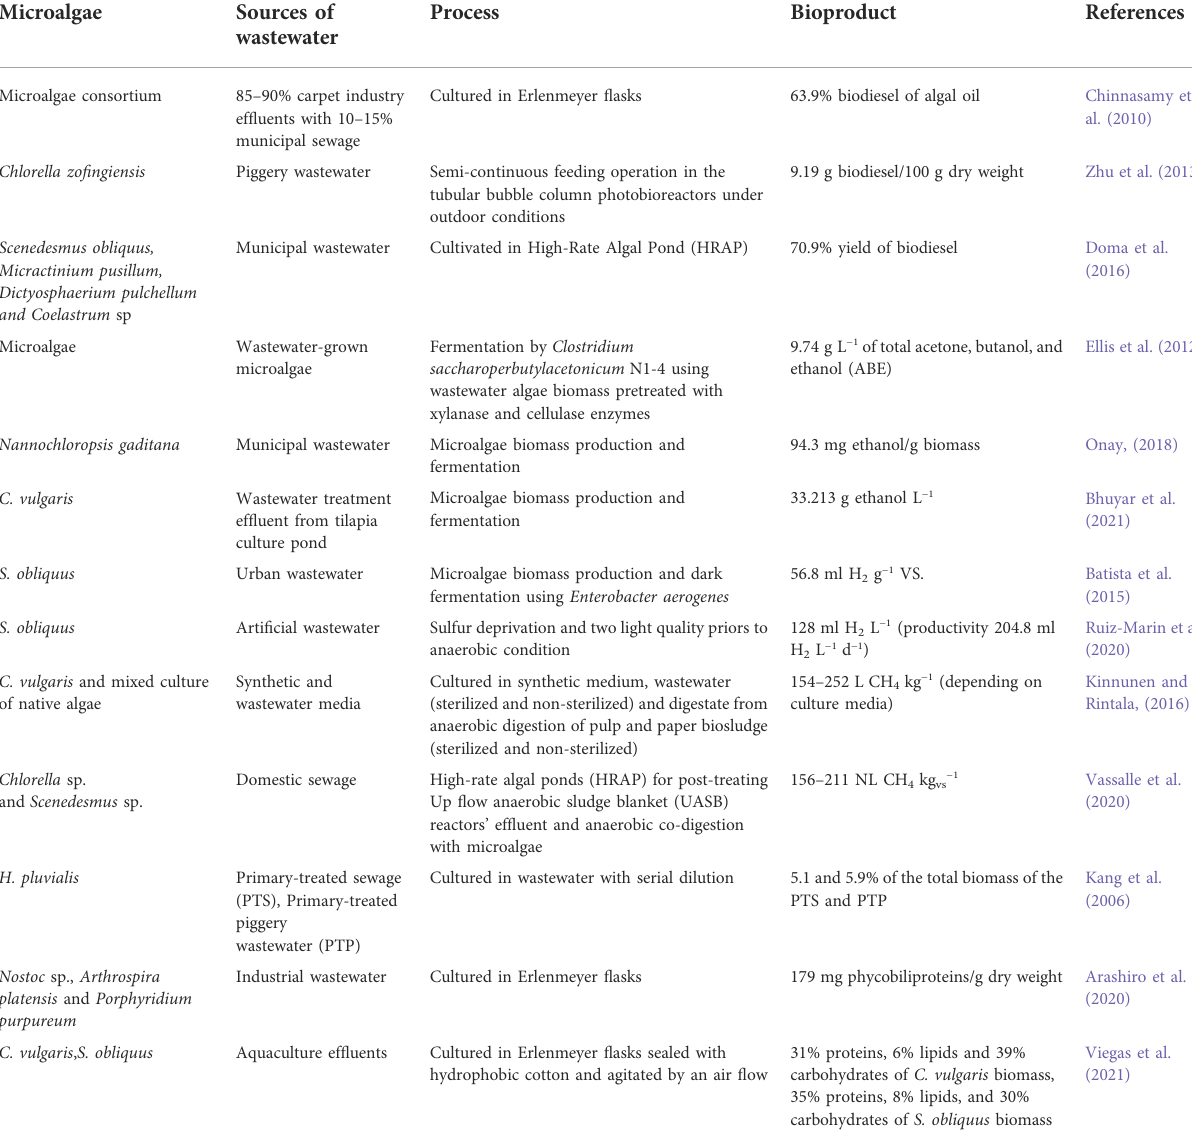
TABLE 1 Several studies of microalgae growth coupled with wastewater treatment for biofuel and other value-added compounds